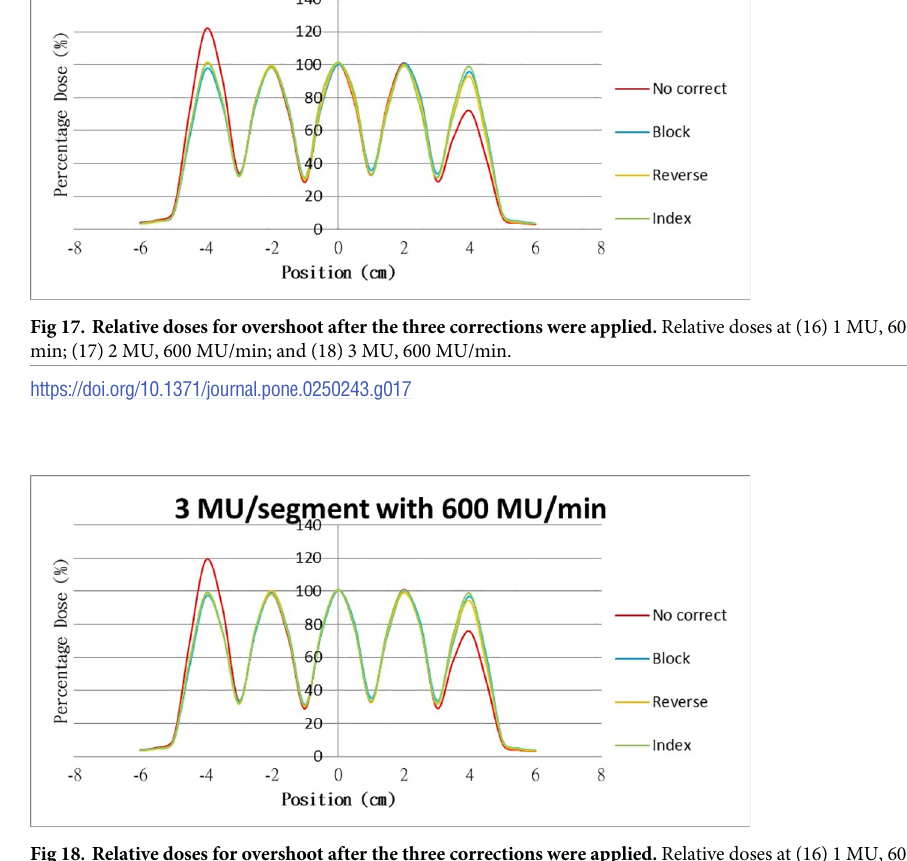
to predict for a treatment field using index correction. Compared with block correction and index correction, reverse-sequence correction results in greater time savings when the MLC.